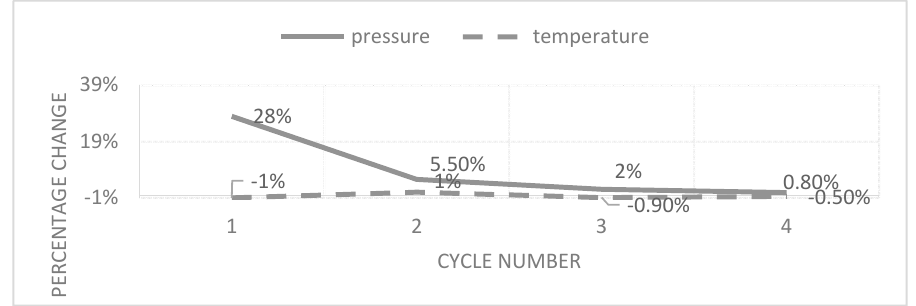
Figure 8. Effect of the engine rotations’ number on the maximum temperature and pressure showing the cycle independency.